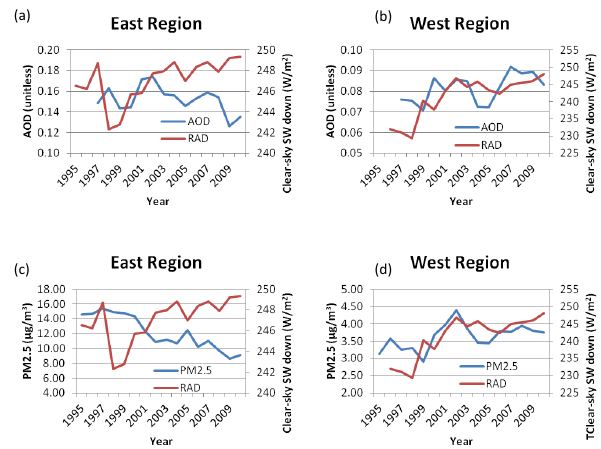
Fig. 10. (a–b) Represent annual mean of AOD vs. clear-sky SW radiation (RAD) from 1995 through 2010. (c–d) Represent an- nual mean of PM 2 . 5 vs. clear-sky SW radiation (RAD) from 1995 through 2010. Left side is for east region while right side is for west